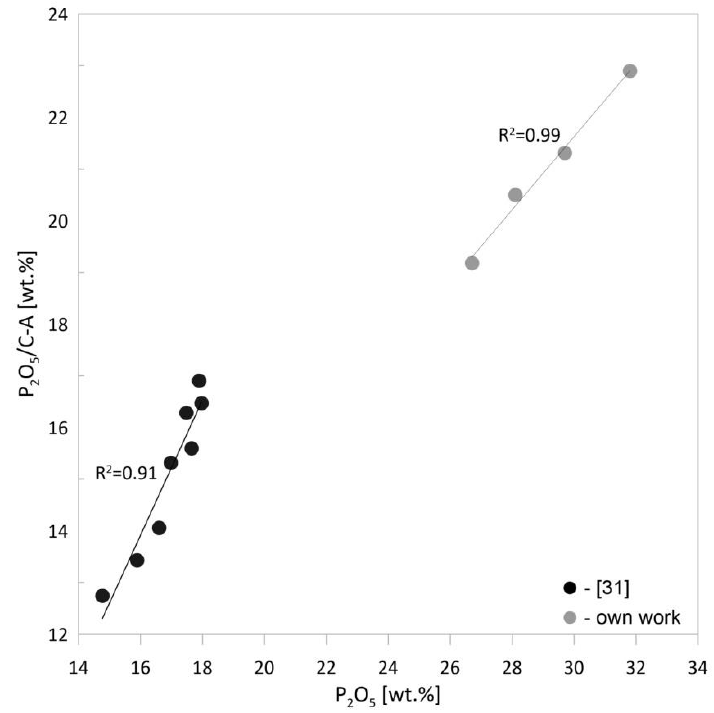
Figure 12. The relationship between the total phosphorus content (P 2 O 5 ; determined by XRF) and the content of phosphorus soluble in 2% citric acid (P 2 O 5